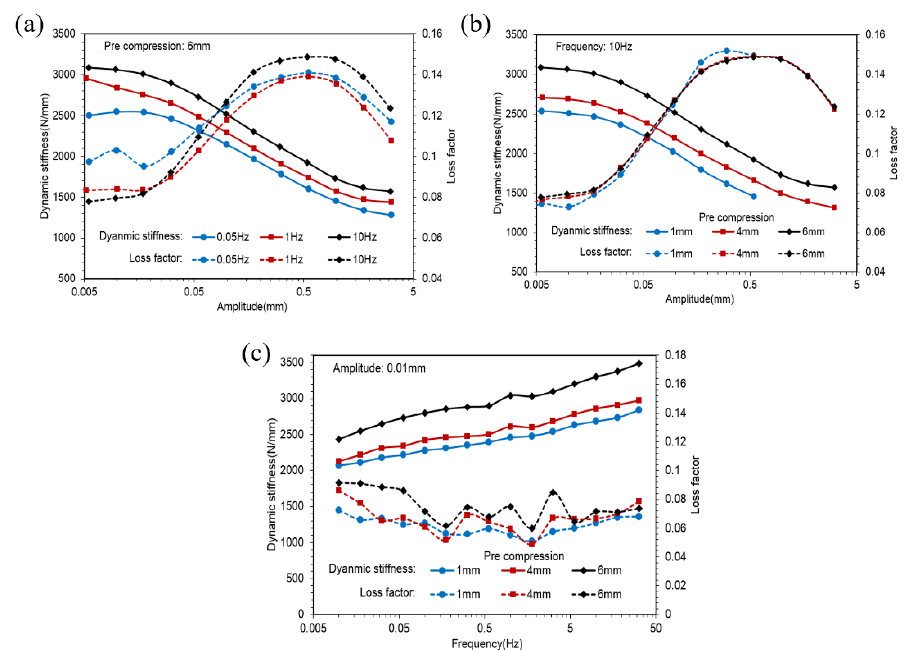
Figure 6. Dynamic stiffness and loss factors curves of the CT rubber spring. ( a ) Dynamic stiffness and loss factors of the CT rubber spring against the amplitude in different frequencies. ( b ) Dynamic stiffness and loss factors of the CT rubber spring against the amplitude in different pre-compression. ( c ) Dynamic stiffness and loss factors of the CT rubber spring against the frequency in different amplitudes.